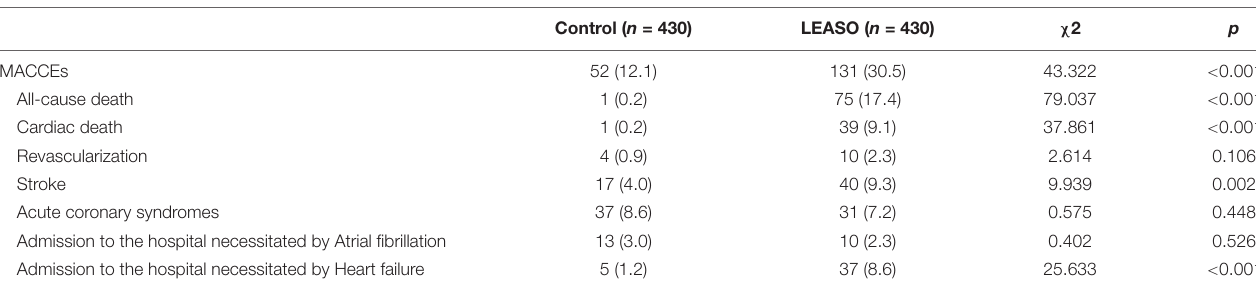
TABLE 2 | Incidence of MACCEs of LEASO group and control